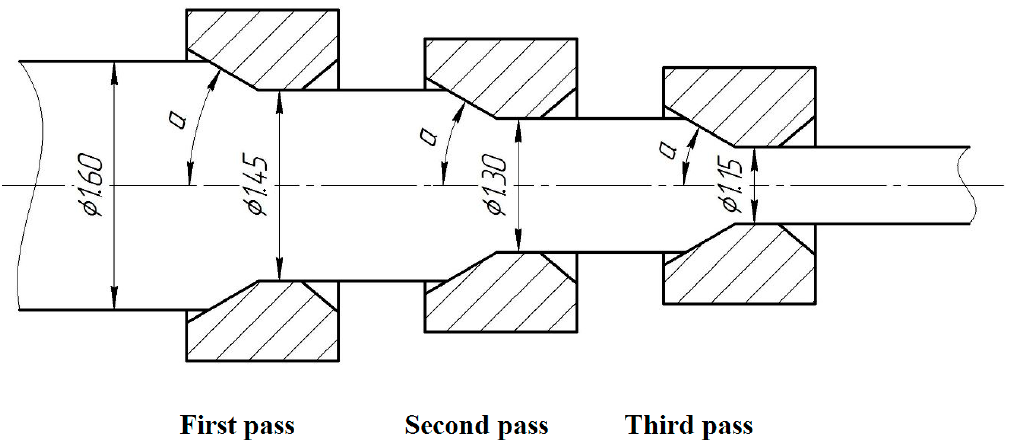
Figure 2. Schematic diagram of the multipass drawing process; unit: mm.